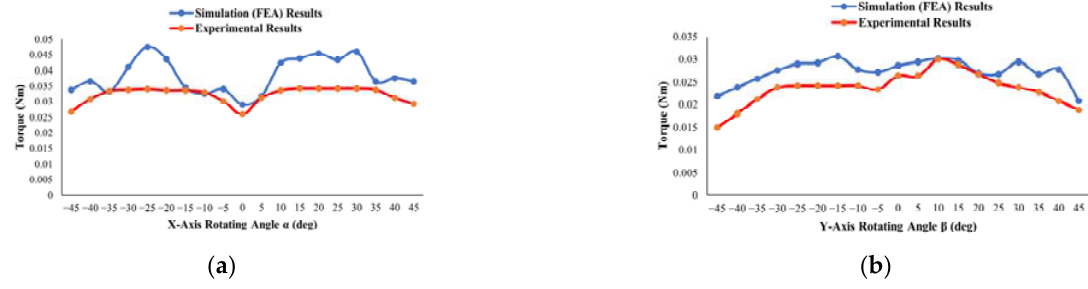
Figure 21. Measured and simulation results for the torque values of the motor rotating around the X ‐ axis from α = 0° to α = ±45° ( a ) rotating around the Y ‐ axis from β = 0° to β = ±45° ( b ).